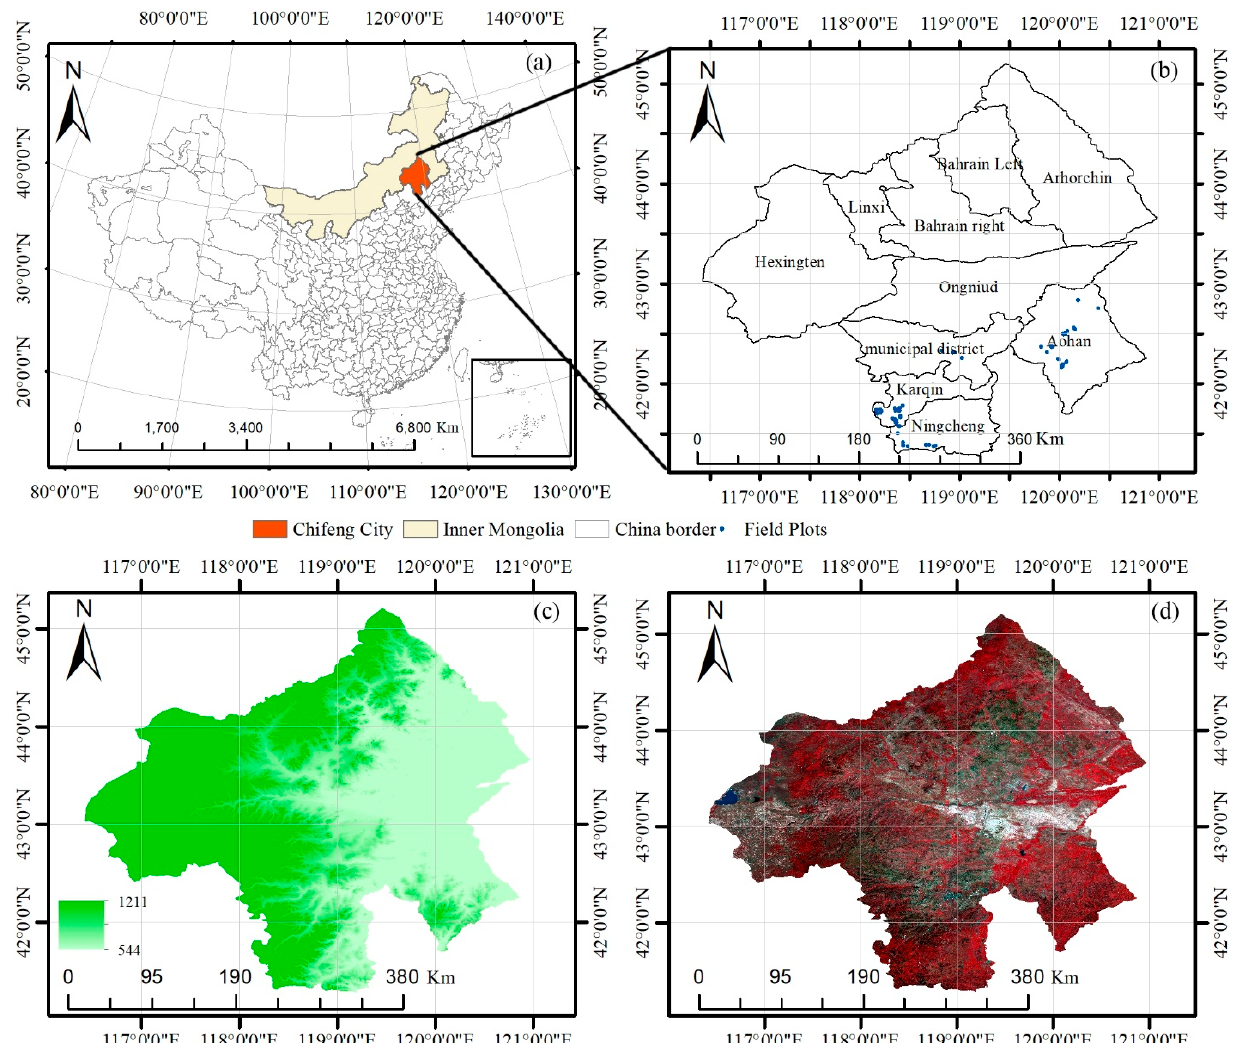
Figure 1. The regional division ( a ), the location of the study area and field survey samples ( b ), the terrain ( c ), and the false-color (i.e., RGB: 5-4-3) composite of Landsat 8 OLI ( d ).